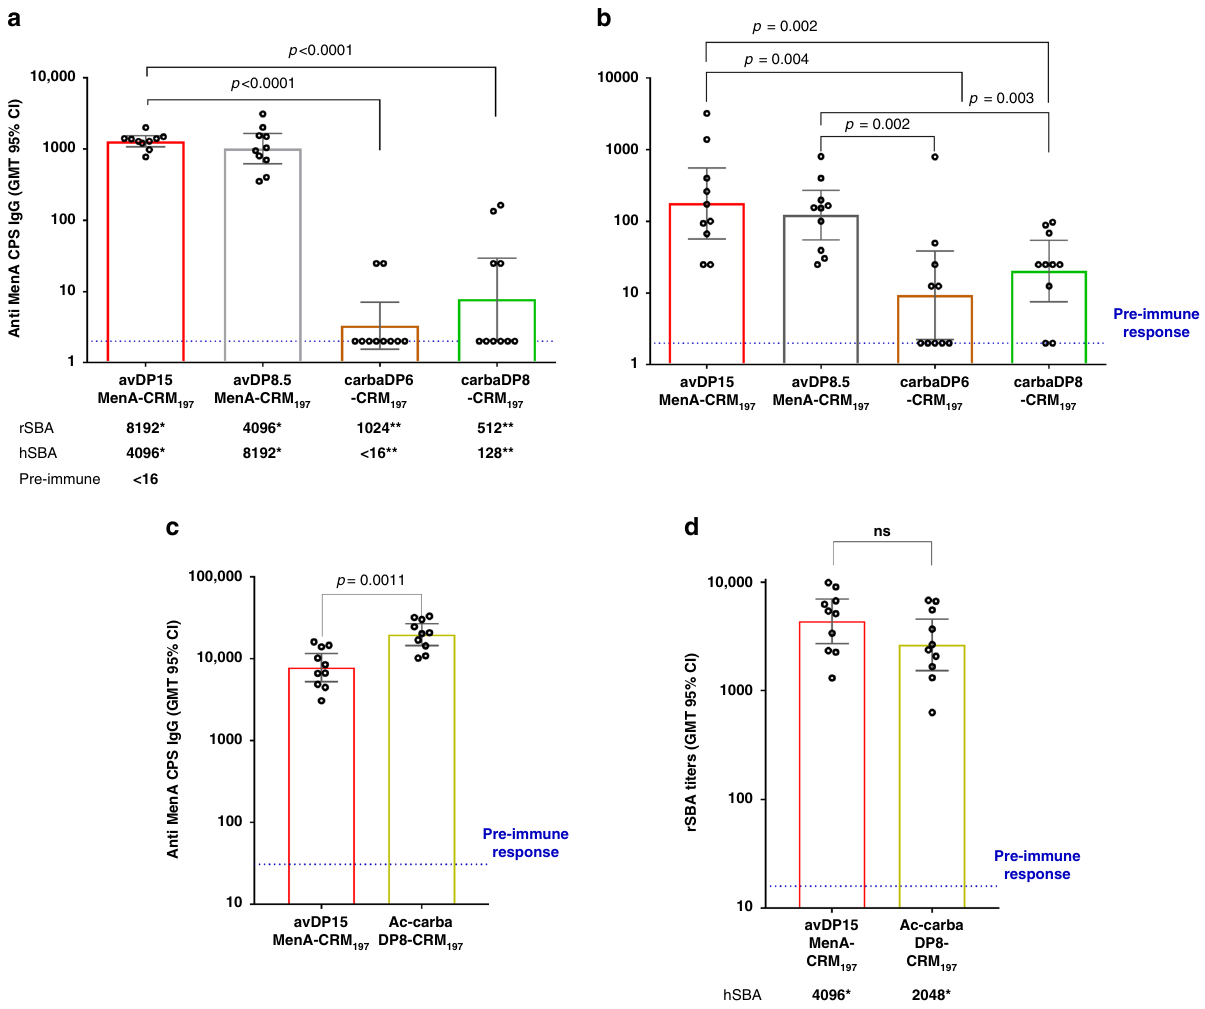
Fig. 5 Immune response elicited by the neo-glycoconjugates. Antibody titers are reported in the a – c panel as Geometric Mean (horizontal bar) with the 95% of CI (vertical bar). rSBA titers are reported in the d panel as Geometric Mean (horizontal bar) with the 95% of CI (vertical bar). Two-tailed Mann- Whitney test was used to compare ranks; n = 10. Pre-immune was the negative control in both type of analysis. a Anti-MenA IgG titers estimated in individual murine sera after the second boost against the natural MenA CPS. p < 0.0001 between avDP~15 MenA and carbaDP6/DP8 conjugates. b Anti- deOAc MenA IgG titers determined against the de-O-acetylated MenA CPS conjugated to HSA. p = 0.002 between avDP~15 and carbaDP8 conjugates, and between avDP8.5 and carbaDP6 conjugates; p = 0.003 between avDP8.5 and carbaDP8 conjugates; and p = 0.004 between avDP~15 and carbaDP6 conjugates comparison. c Anti-MenA IgG titers estimated in individual sera after the second boost using MenA CPS for coating. p = 0.0011 comparing avDP15 and Ac-carbaDP8 conjugates. d Human and rabbit serum bactericidal titers measured after the third injection on pooled and individual mice sera, respectively. Not signi fi cant differences were found comparing the ranks. Immunizations were conducted in duplicates and data from a representative experiment are here shown. *Human and rabbit SBA titers measured after the third injection on pooled sera; **Human and rabbit SBA titers measured after the third injection on pooled sera from responder